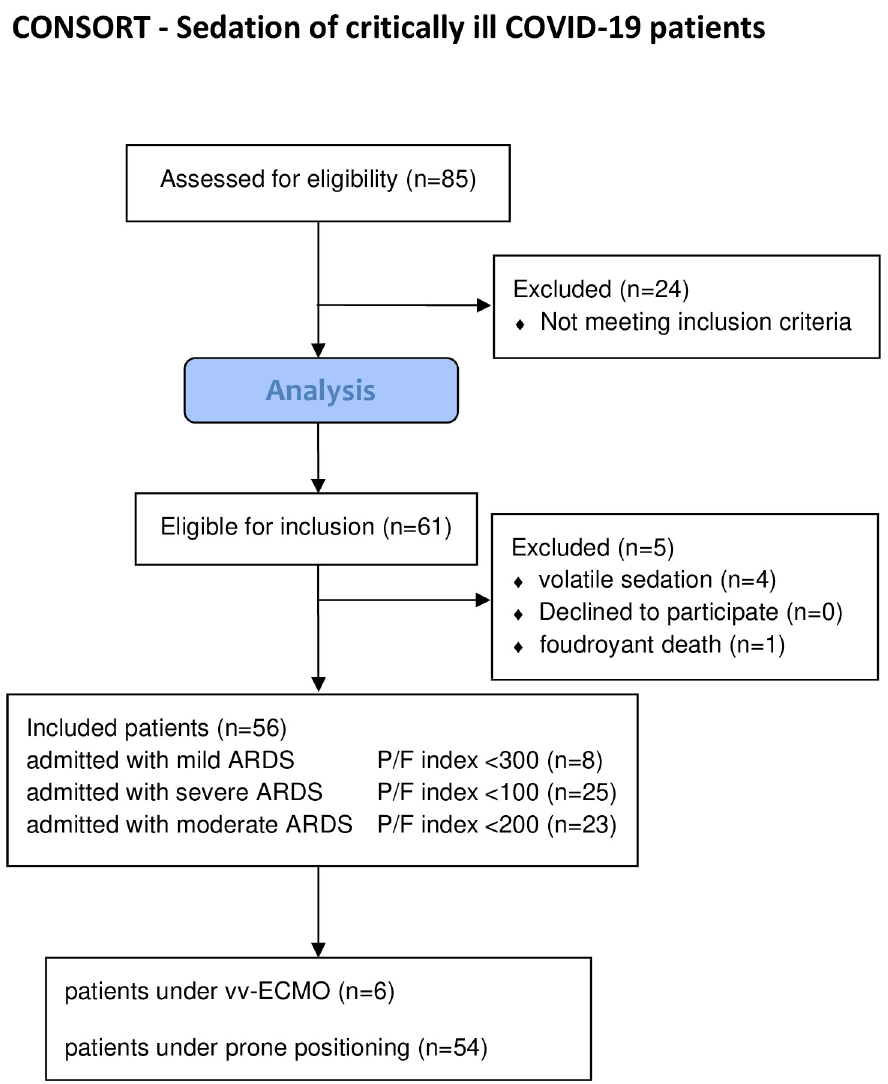
Fig 1. Flow chart of patients included into the study (according to the CONSORT criteria). ARDS = acute respiratory distress syndrome, P/F index = Horovitz Oxygenation index = p a O 2 /F i O 2 , vv-ECMO = veno-venous-extra corporeal membrane